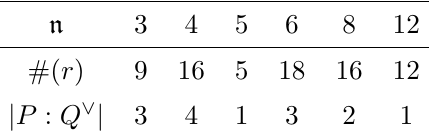
, and they are thus (cid:12)nite r (cid:28) =0